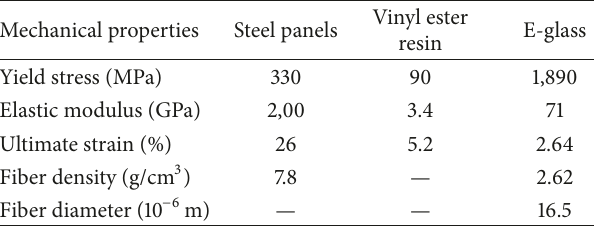
Table 1: Mechanical properties of steel, glass fiber, and matrix resin. Mechanical